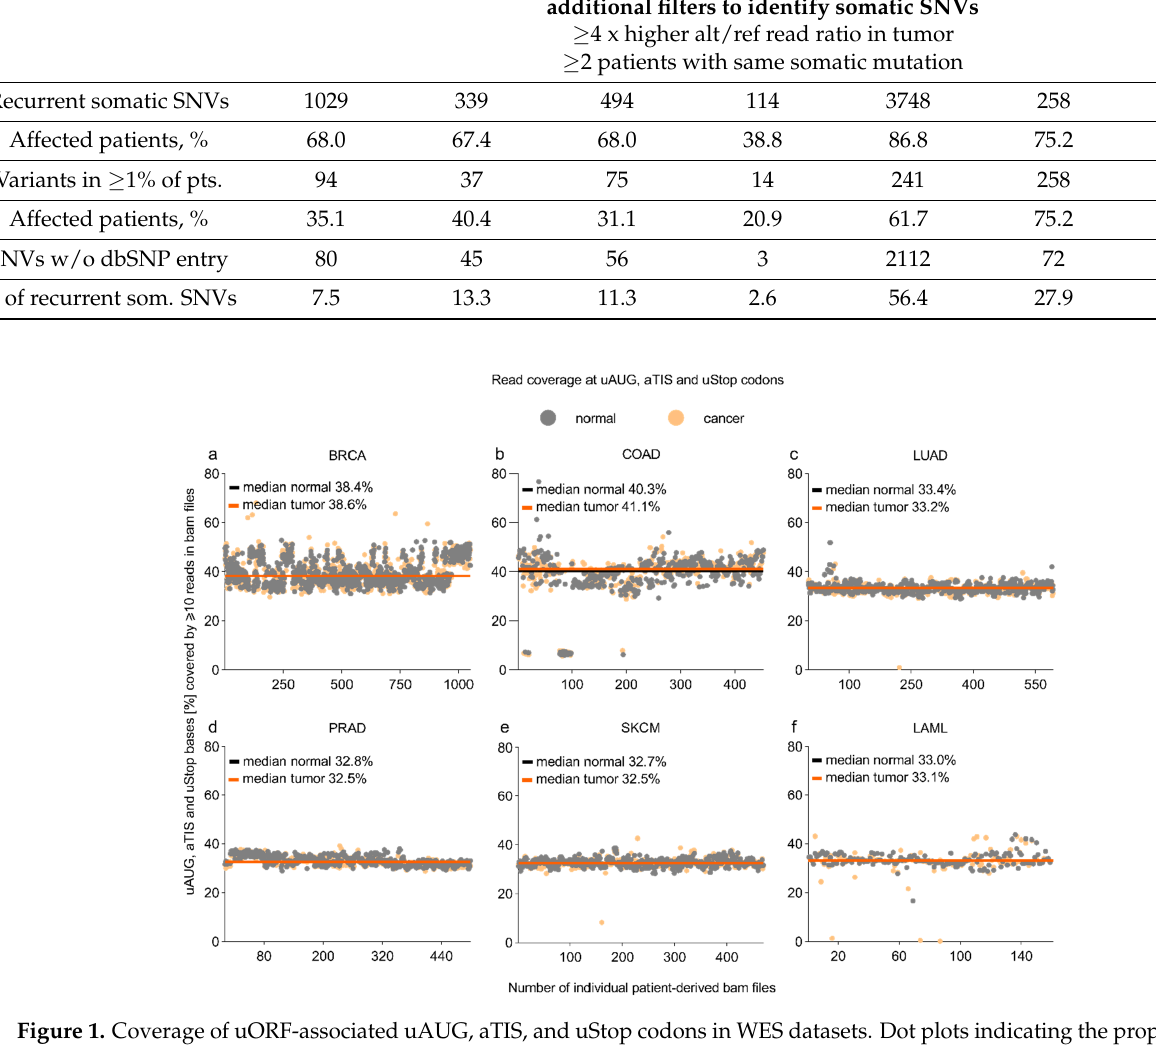
Figure 1. Coverage of uORF-associated uAUG, aTIS, and uStop codons in WES datasets. Dot plots indicating the proportion of genomic positions of canonical (uAUG) and alternative initiation sites (aTISs), as well as the associated termination codons (uStops) covered by ≥ 10 reads in tumor (orange dots) and normal control (grey dots) patient samples. The coverage analysis was performed using TCGA-derived whole-exome sequencing BAM files of ( a ) breast invasive carcinoma (BRCA), ( b ) colon adenocarcinoma (COAD), ( c ) lung adenocarcinoma (LUAD), ( d ) prostate adenocarcinoma (PRAD), ( e ) skin cutaneous melanoma (SKCM), ( f ) acute myeloid leukemia (LAML), and the related normal controls. Orange and black lines indicate the median coverage of entity-specific tumor and normal control samples, respectively.